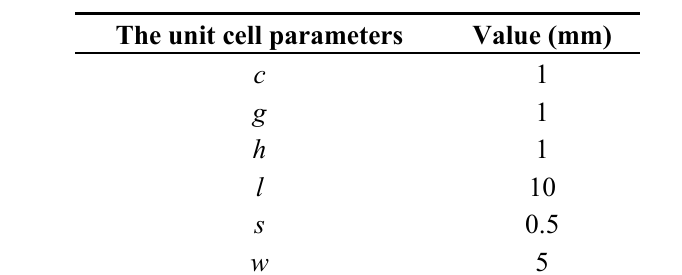
Table 1. Design specifications of the unit